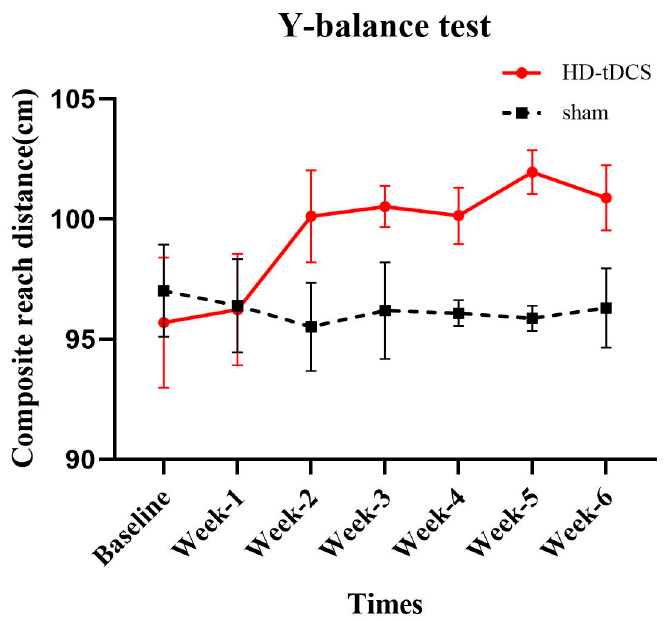
Figure 4. Y-balance test performance (mean ± SE). The composite reach distance in the HD-tDCS group was significantly improved ( p < 0.05), but there was no significant change in the sham group ( p > 0.05).